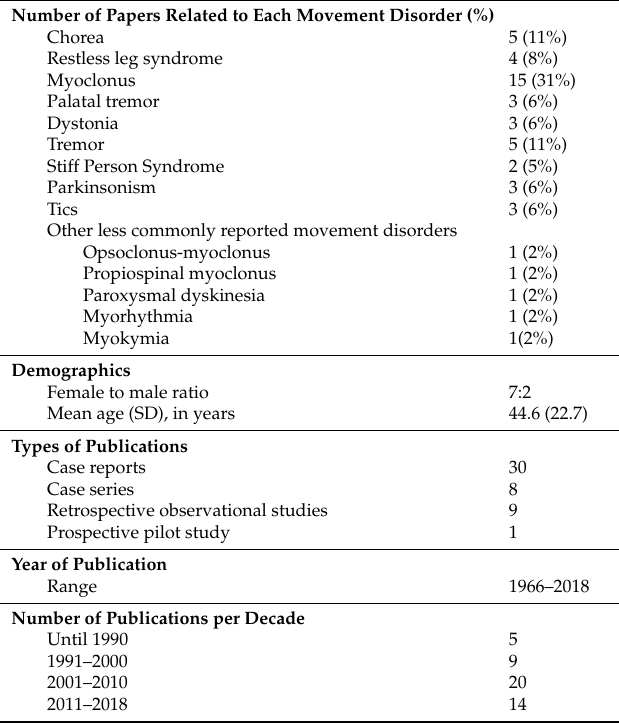
Figure 1. PRISMA chart. To be included in this review, the articles had to meet the following inclusion criteria: (1) To be original clinical papers, (2) to study human subjects, (3) to involve single cases, case series or retrospective observational studies with the combination of Coeliac disease (CD) or gluten sensitivity (GS) and movement disorders (MDs). Table 1. Characteristics of the papers included in the review.